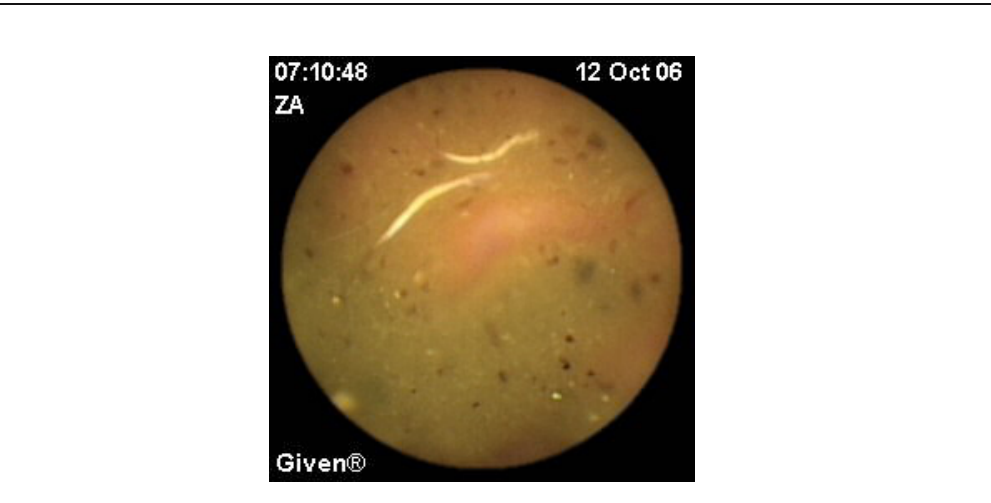
Fig. 1 Multiple worms 5 to 10 mm long were visualized in distal ileum on capsule en-